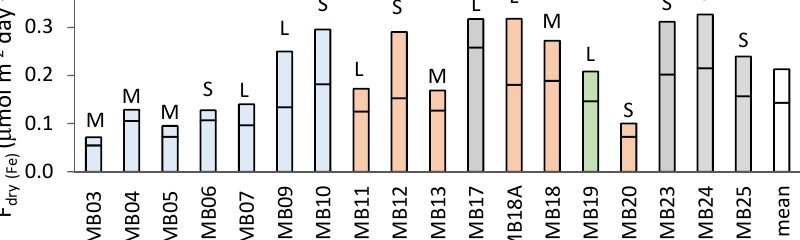
Figure 4. Budget of labile Fe in aerosol deposition. Fractions of soluble (down column) and leachable (upper column) Fe atmospheric concentrations (cFe) ( A ), fractional contributions to the total Fe pool (FFeS) ( B ), and dry deposition fluxes (F dry (Fe) ) ( C ). Column colour indicates sample origin according to backward trajectories: blue- marine, orange- terrestrial, green- mixed, grey- land see land. Index above the column indicates the sample origin according to wind direction: S- sea breeze, M- mixed breeze, and L- land breeze.